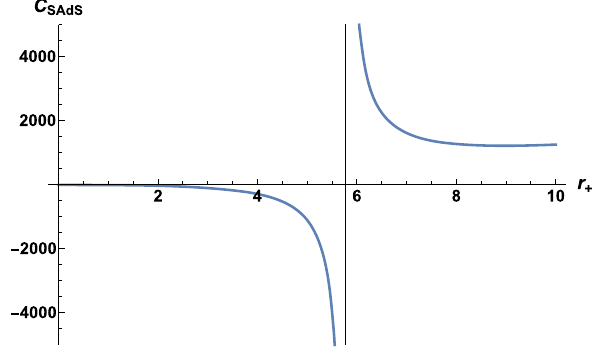
Fig. 4 Plot of heat capacity C SAdS with l = 10 in Einstein gravity. The √ heat capacity blows up at r + = r ∗ = (cid:7)/ 3 = 5 . 7. The thermodynamic stability is based on the sign of heat capacity. The small (unstable) black hole with r + < r ∗ is defined by the negative heat capacity, whereas the large (stable) black hole with r + > r ∗ is defined by the positive heat capacity. This picture persists to C EW with b < (cid:7) 2 / 6 and C α =− 3 β with α < (cid:7) 4 /